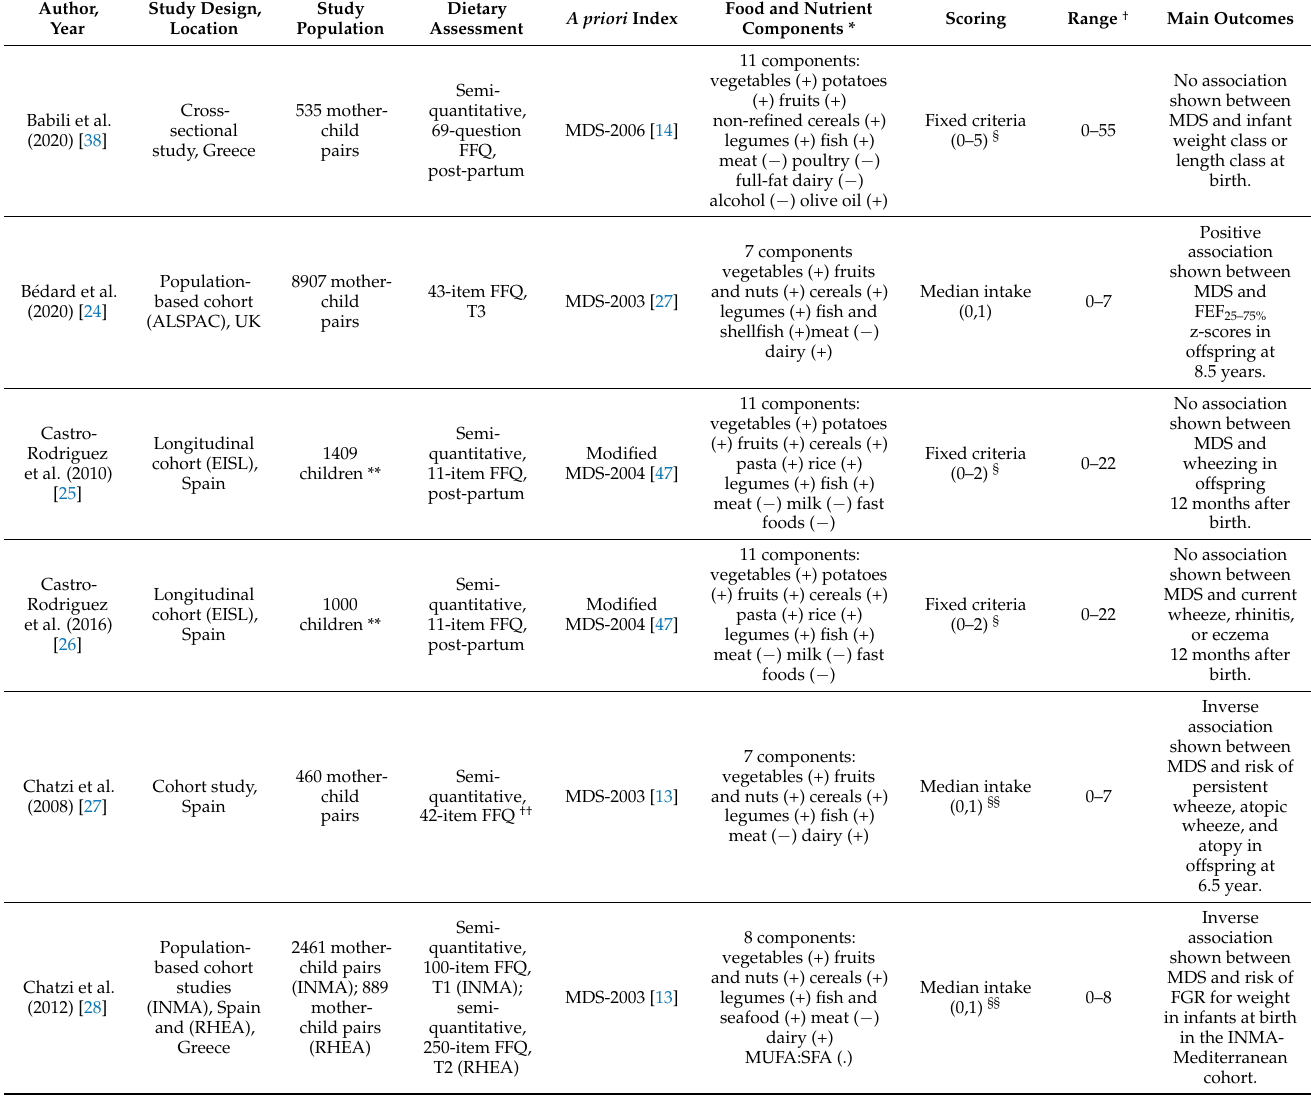
Table 2. Overview of twenty-seven studies using an a priori index to assess maternal adherence to the MD during pregnancy.